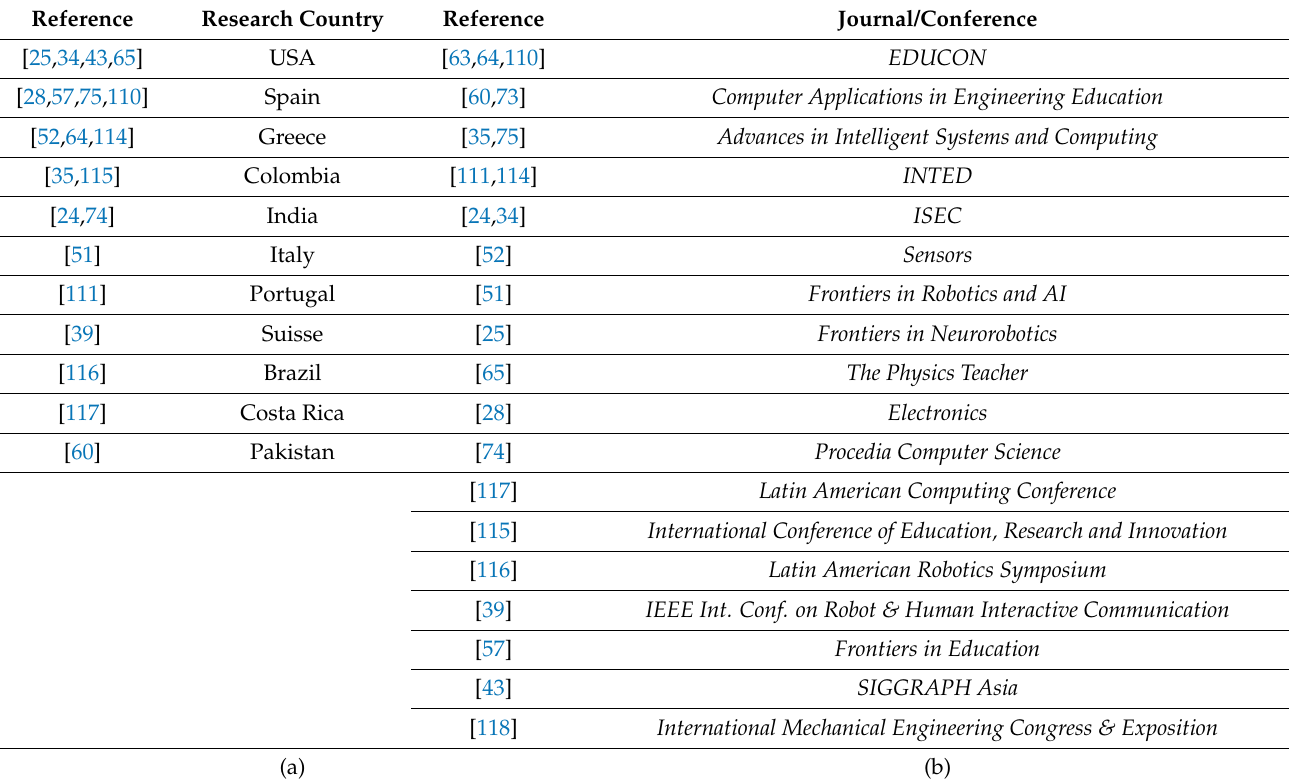
Table 3. Researcher countries and publication in